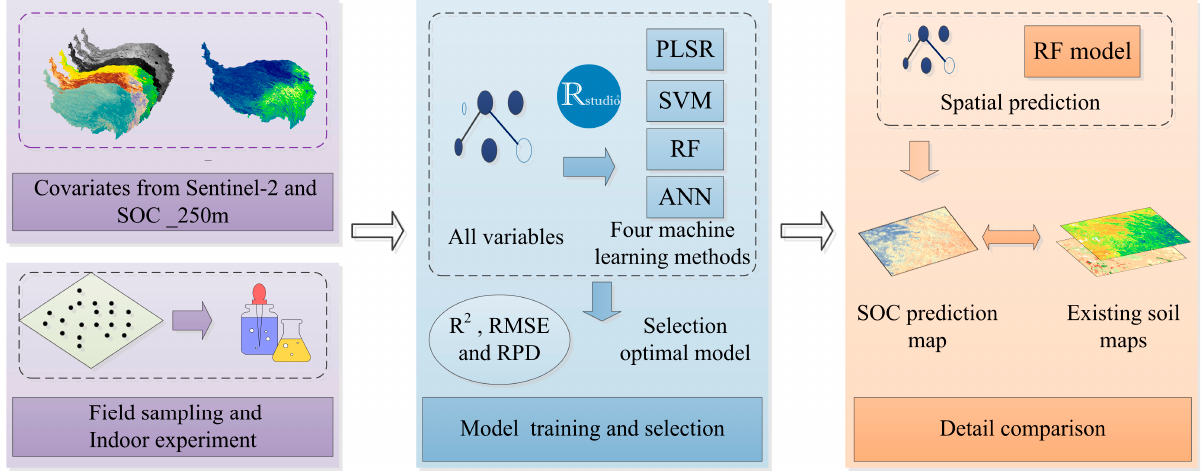
Figure 2. Methodological flowchart for SOC prediction.